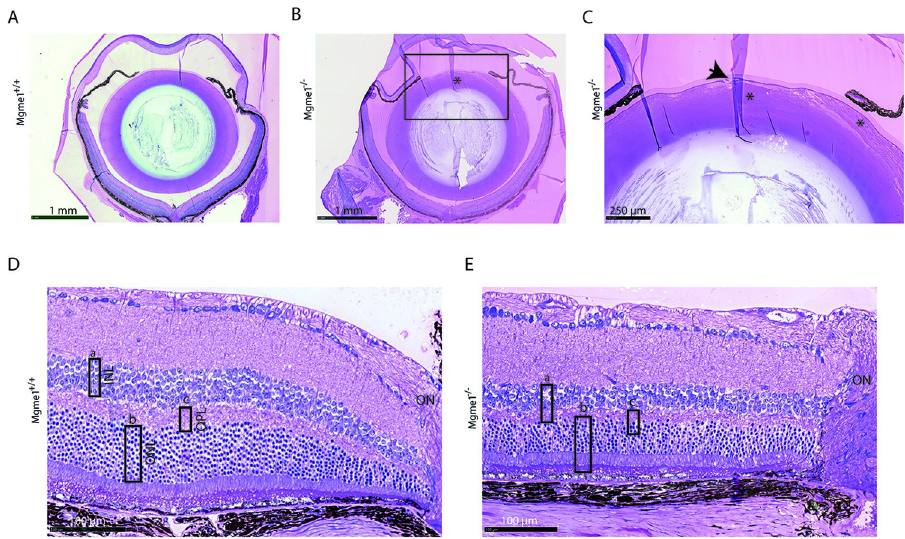
Fig 3. Mgme1 -/- eye tissue histology images show clear alterations of lens and retina morphology. (A) Sections through the Mgme1 +/+ and (B) the Mgme1 -/- eye, indicate at first glance alterations of the lens matrix structure ( � ); (C) enlarged Mgme1 -/- anterior lens image reveals alterations of the lens fiber cells: they are swollen and disorganized ( � ), affecting the stability of the whole lens matrix. Additionally changes are present as to the epithelial cell monolayer, located underneath the lens capsule, shown here as an accumulation of epithelial cells that seem to make place for invaginations of the lens capsular material (arrow). (D) Retinal layers near ON images show an arbitrary thickness evaluation of some of the layers as rectangles (rectangle a—INL, rectangle b—ONL, rectangle c—OPL) in their ‘control’ size that in E. are placed over the Mgme1 -/- retinal layers, to indicate the reduction in all three